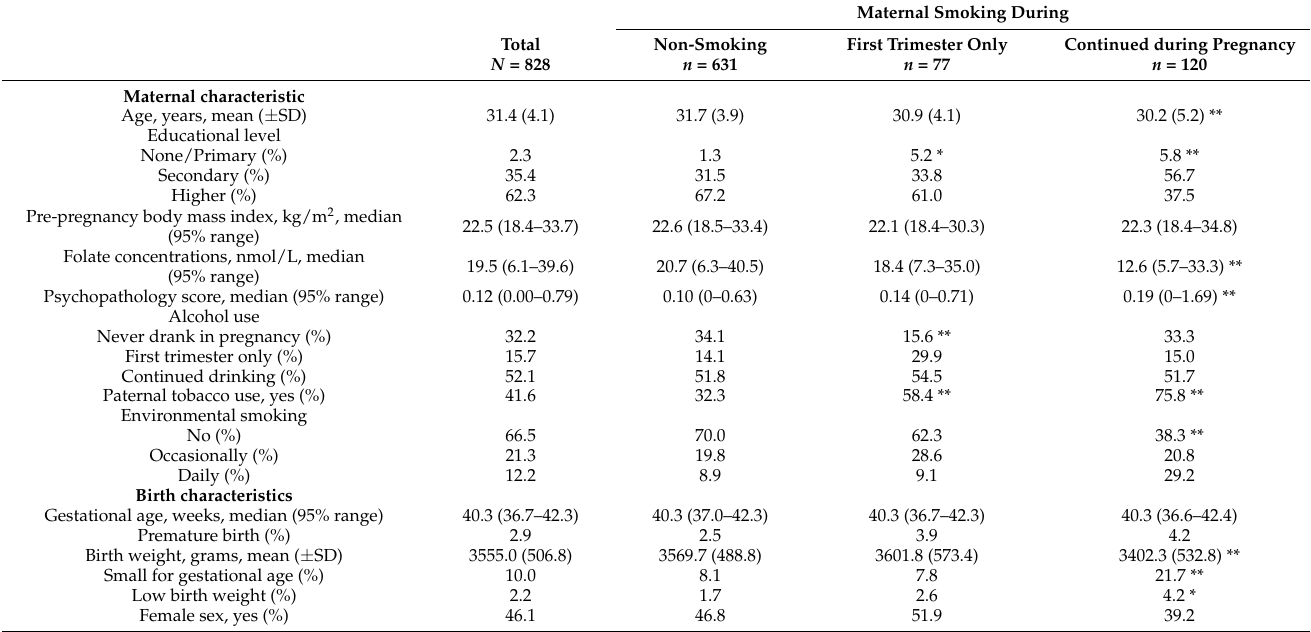
Table 1. Descriptive statistics of the study